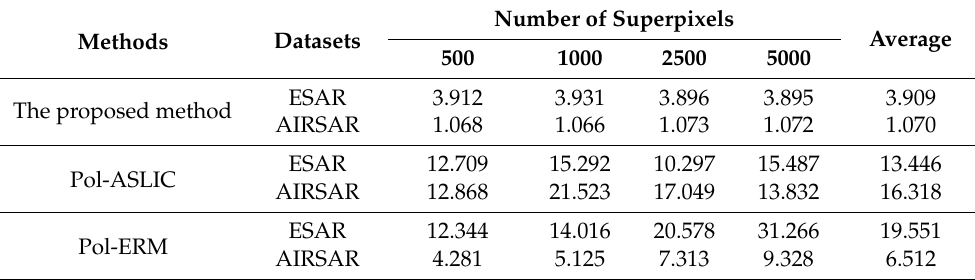
Table 1. Time–cost of different superpixel generation methods for two PolSAR datasets (seconds).